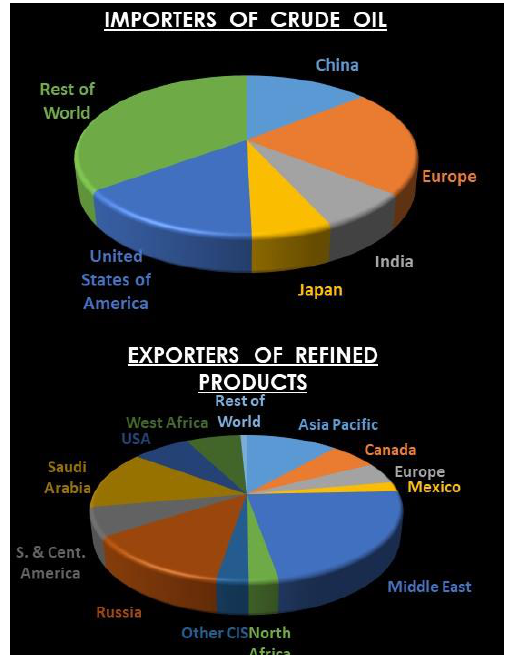
Figure 15. Major exporters and importers of Oil and refined products.